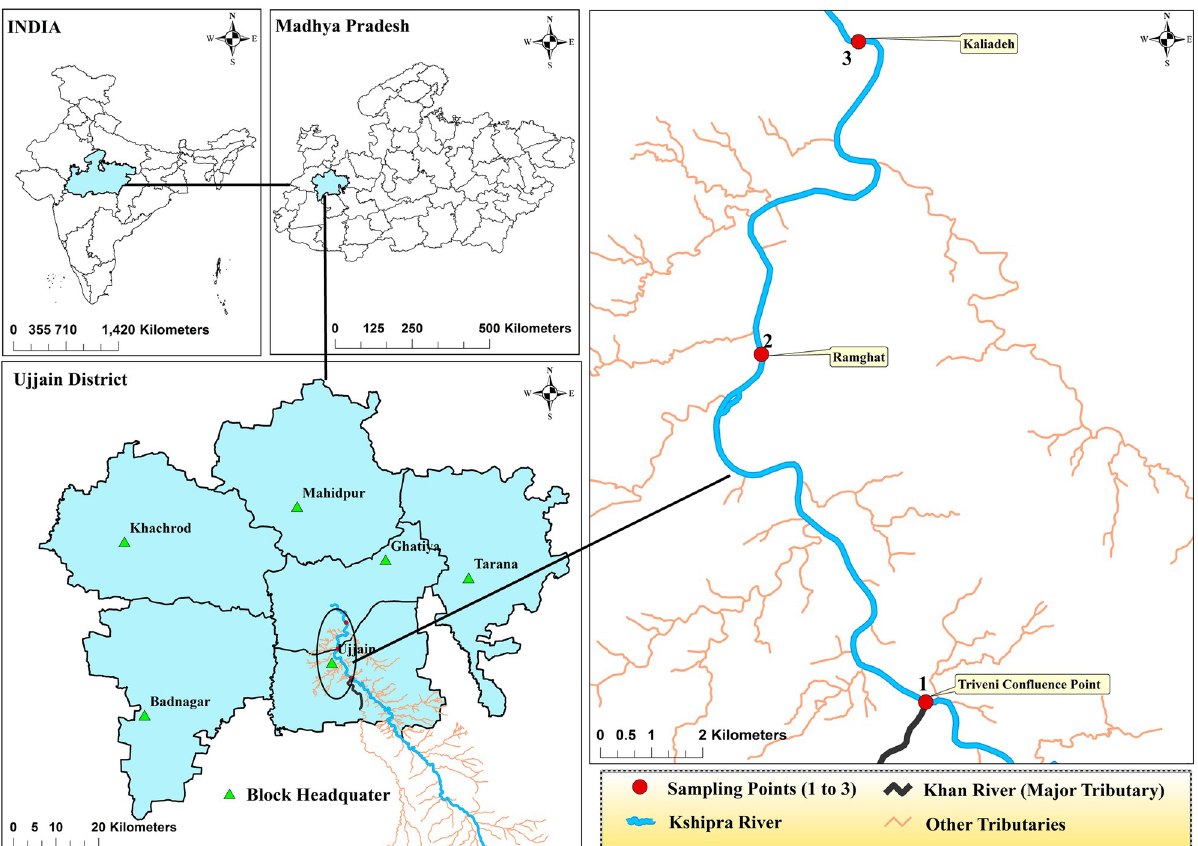
Fig 1. Geographical location of the river Kshipra sites for mass bathing sampling. River Kshipra, River Khan, others tributaries and locations of sampling points were obtained from base map of ArcInfo and Google image and through field Survey. Shp-files were generated using ArcMap version 10. Map boundaries of India, Madhya Pradesh and districts were taken from GADM database (https://gadm.org/) where these are available freely for academic purposes. Jammu and Kashmir and Ladakh were treated as one administrative division as the boundary maps separating the two were not available in retrieved